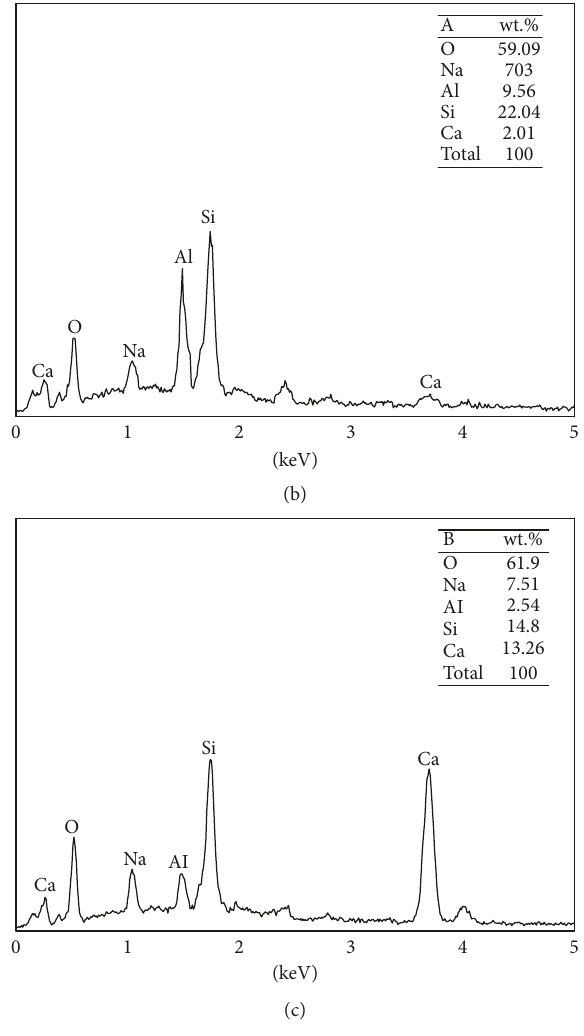
Figure 9: SEM/EDS analysis of the geopolymer specimens at 75%